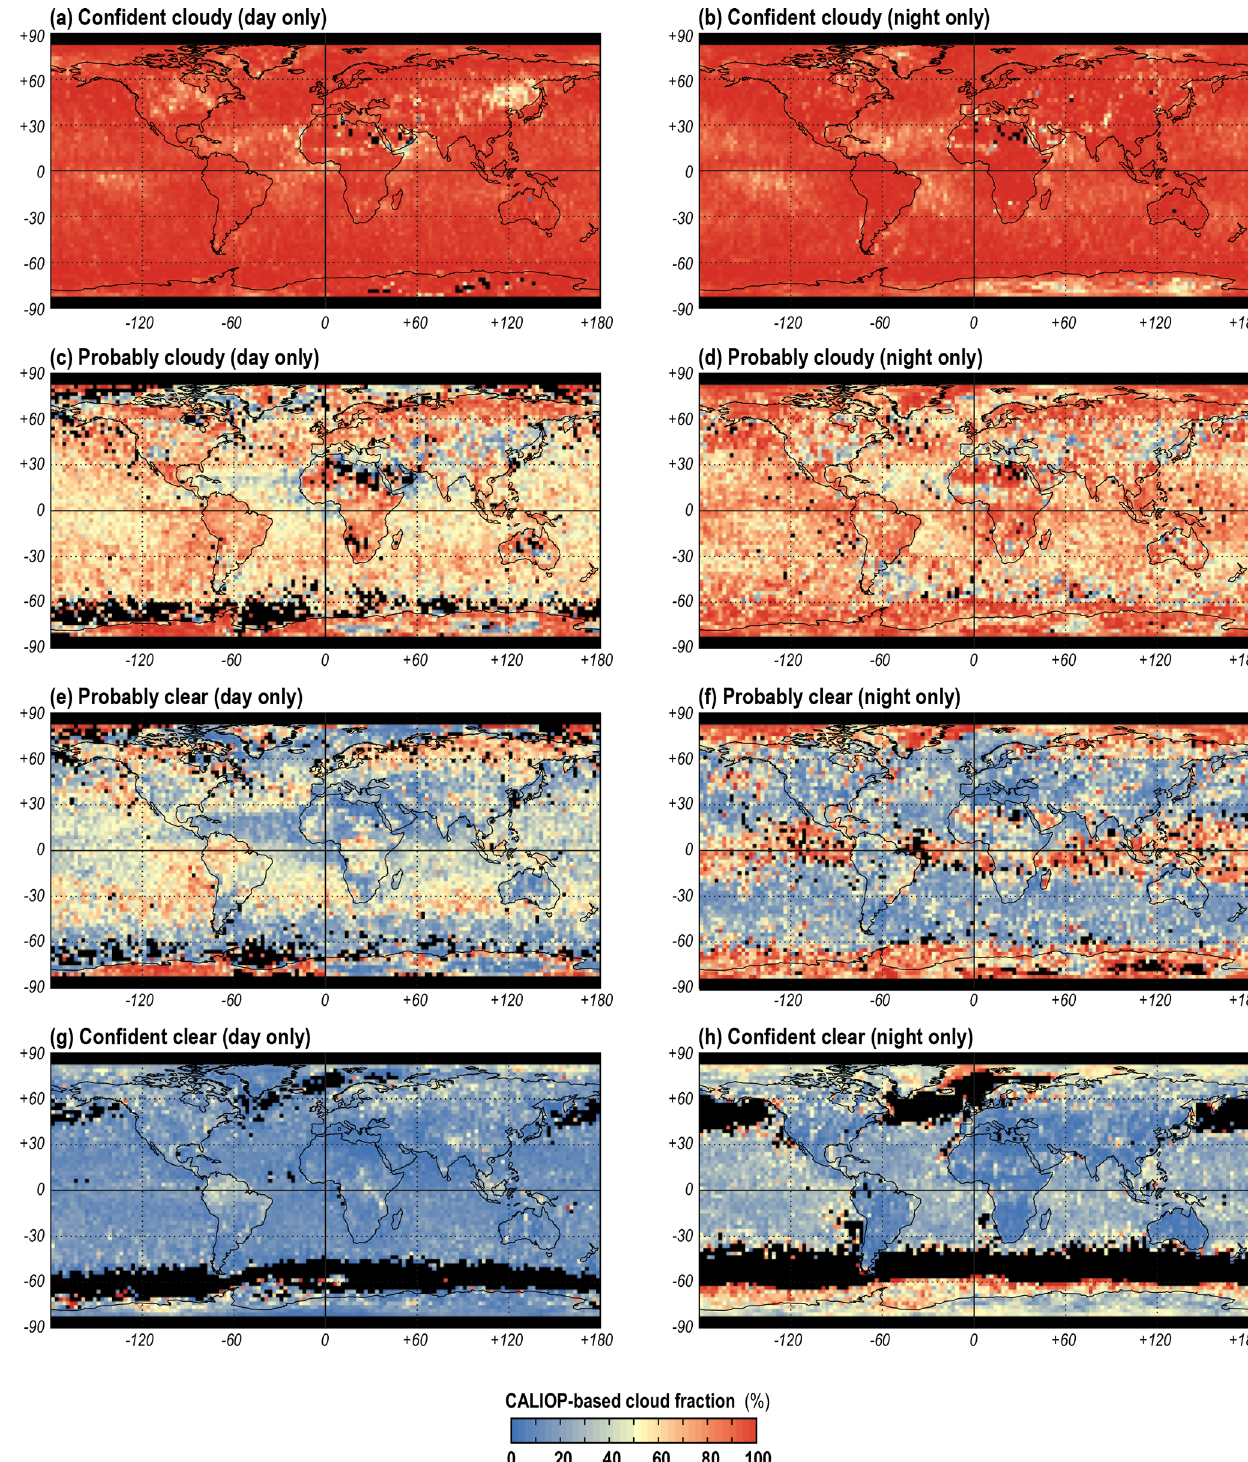
Figure 3. CALIOP-based cloud fraction for MODIS cloud mask